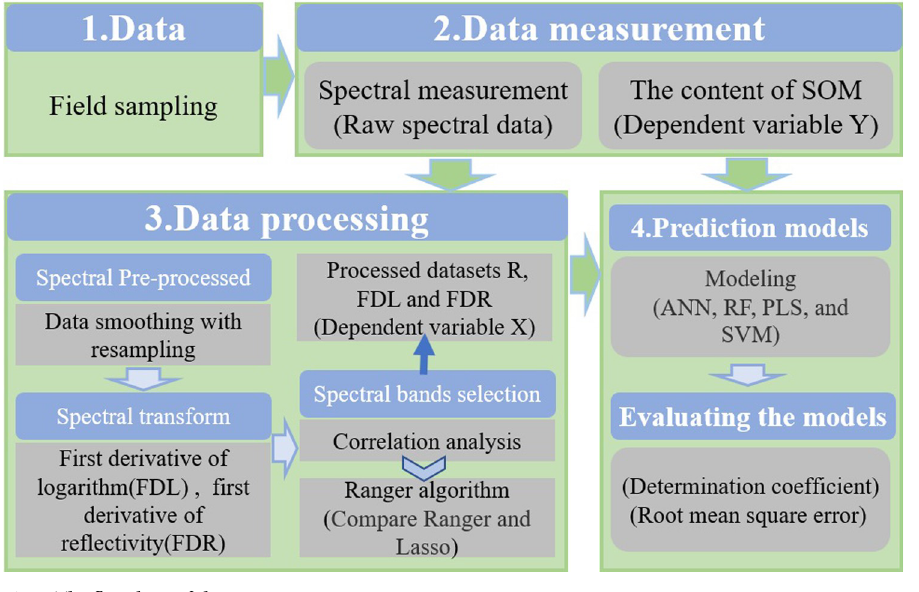
Fig 2. The flowchart of the paper.